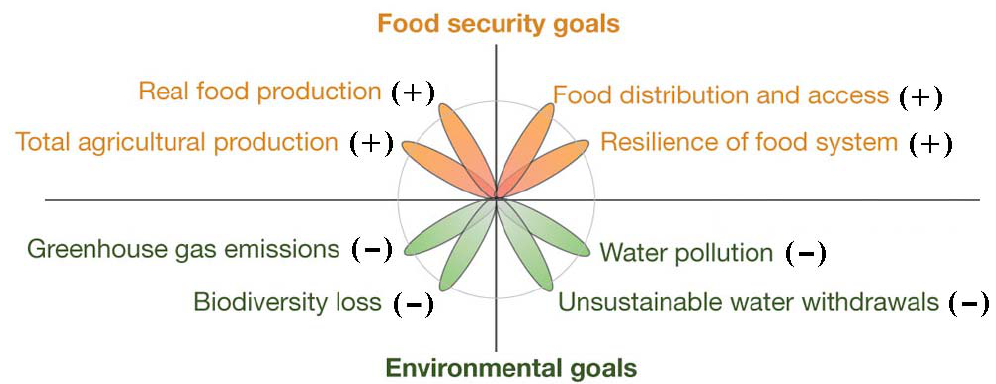
Figure 3. Environmental (bottom) and food security goals (top). The signs after the different items indicate if an increase is necessary (+), respectively, or a reduction ( − ) (adapted from